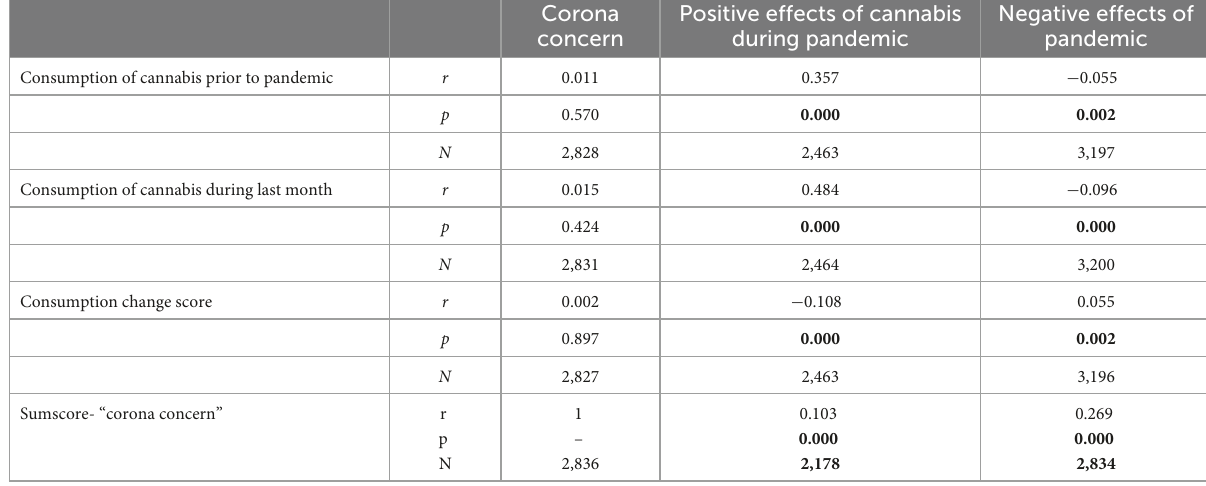
TABLE 2 Spearman’s correlation coefficients of corona-related positive effects of cannabis, negative sequelae, and concerns related to the COVID-19 crisis with consumption quantities.